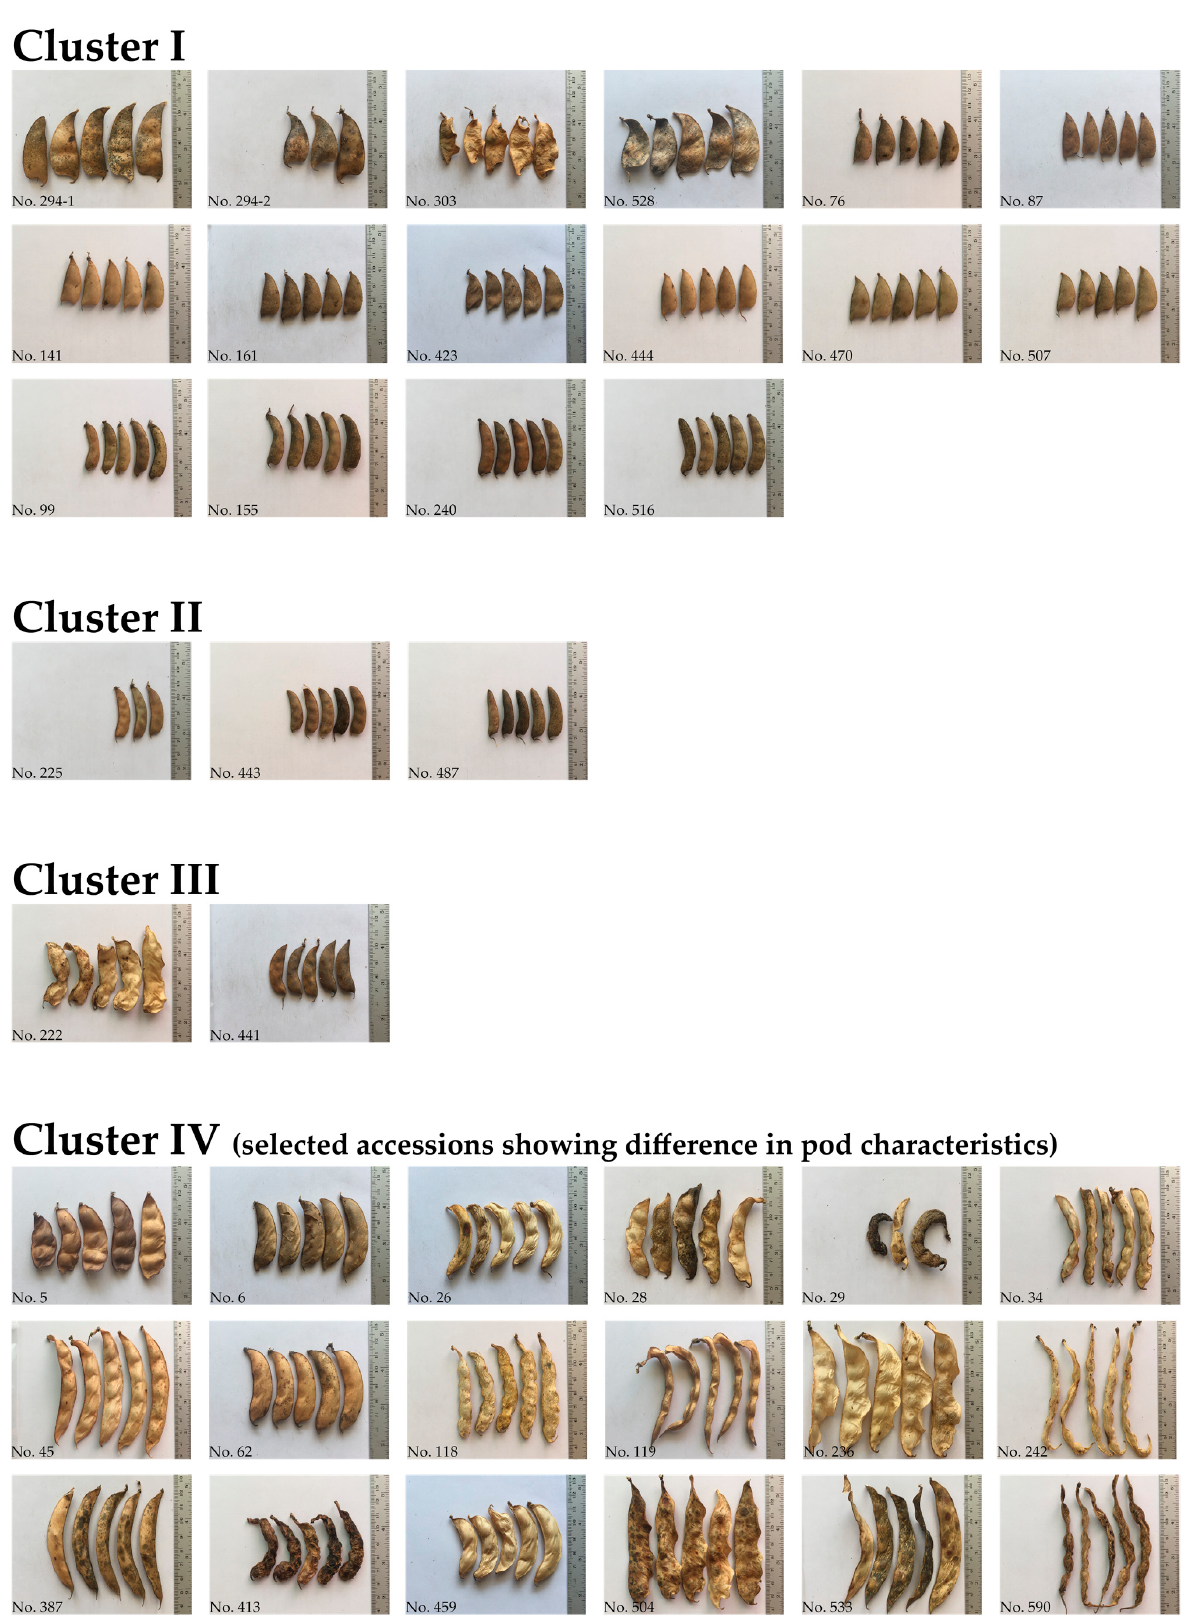
Figure 3. Pod characteristics of some lablab accessions in each genetic cluster determined by UPGMA cluster analysis.